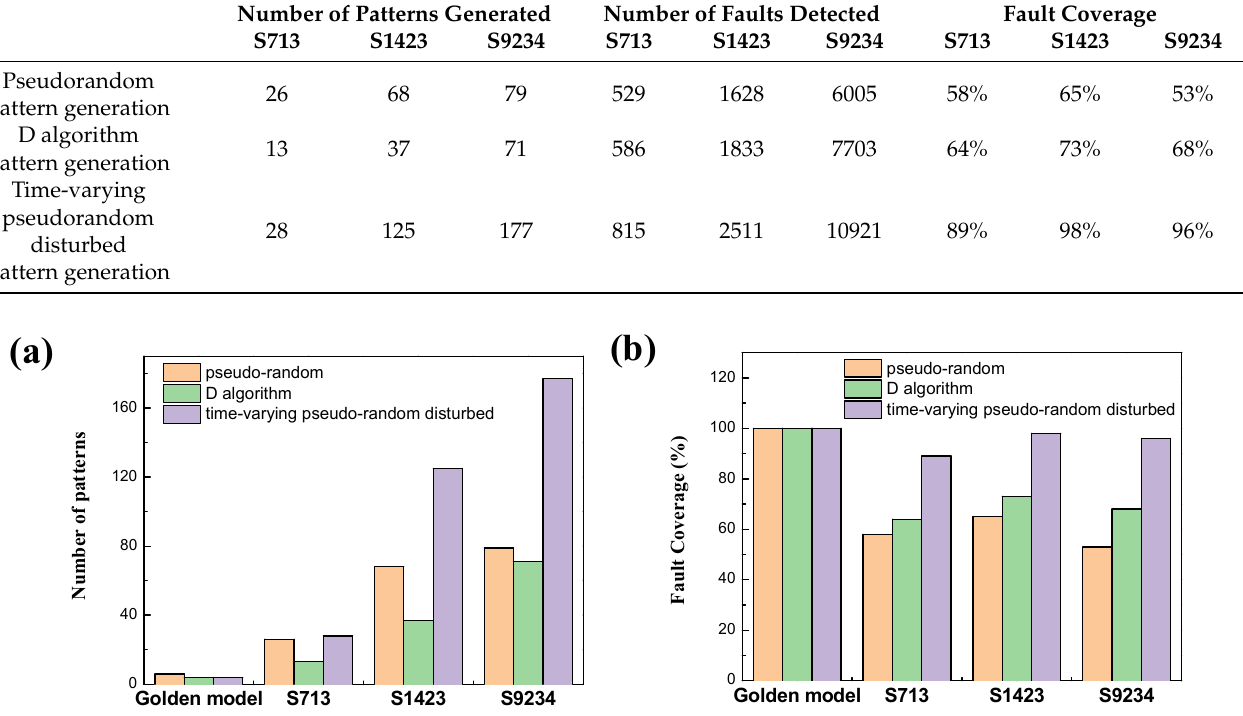
Figure 7. Generated results of each algorithm. ( a ) Number of patterns. ( b ) Fault coverage.